Question: Is the quantity shown trending increasing or decreasing?
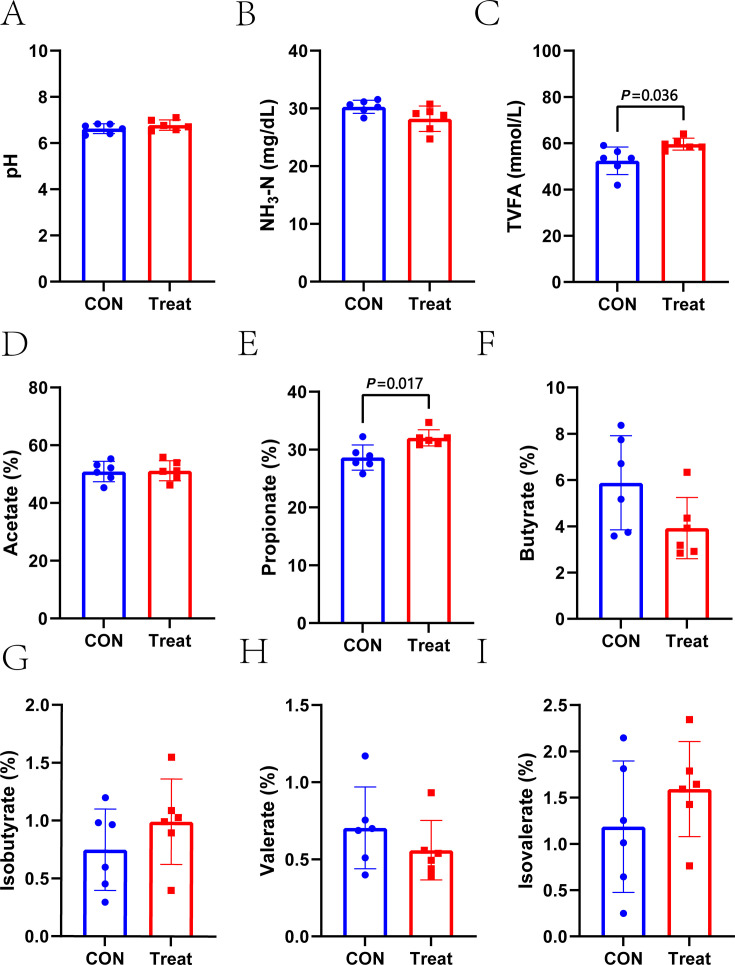
Answer: increasing